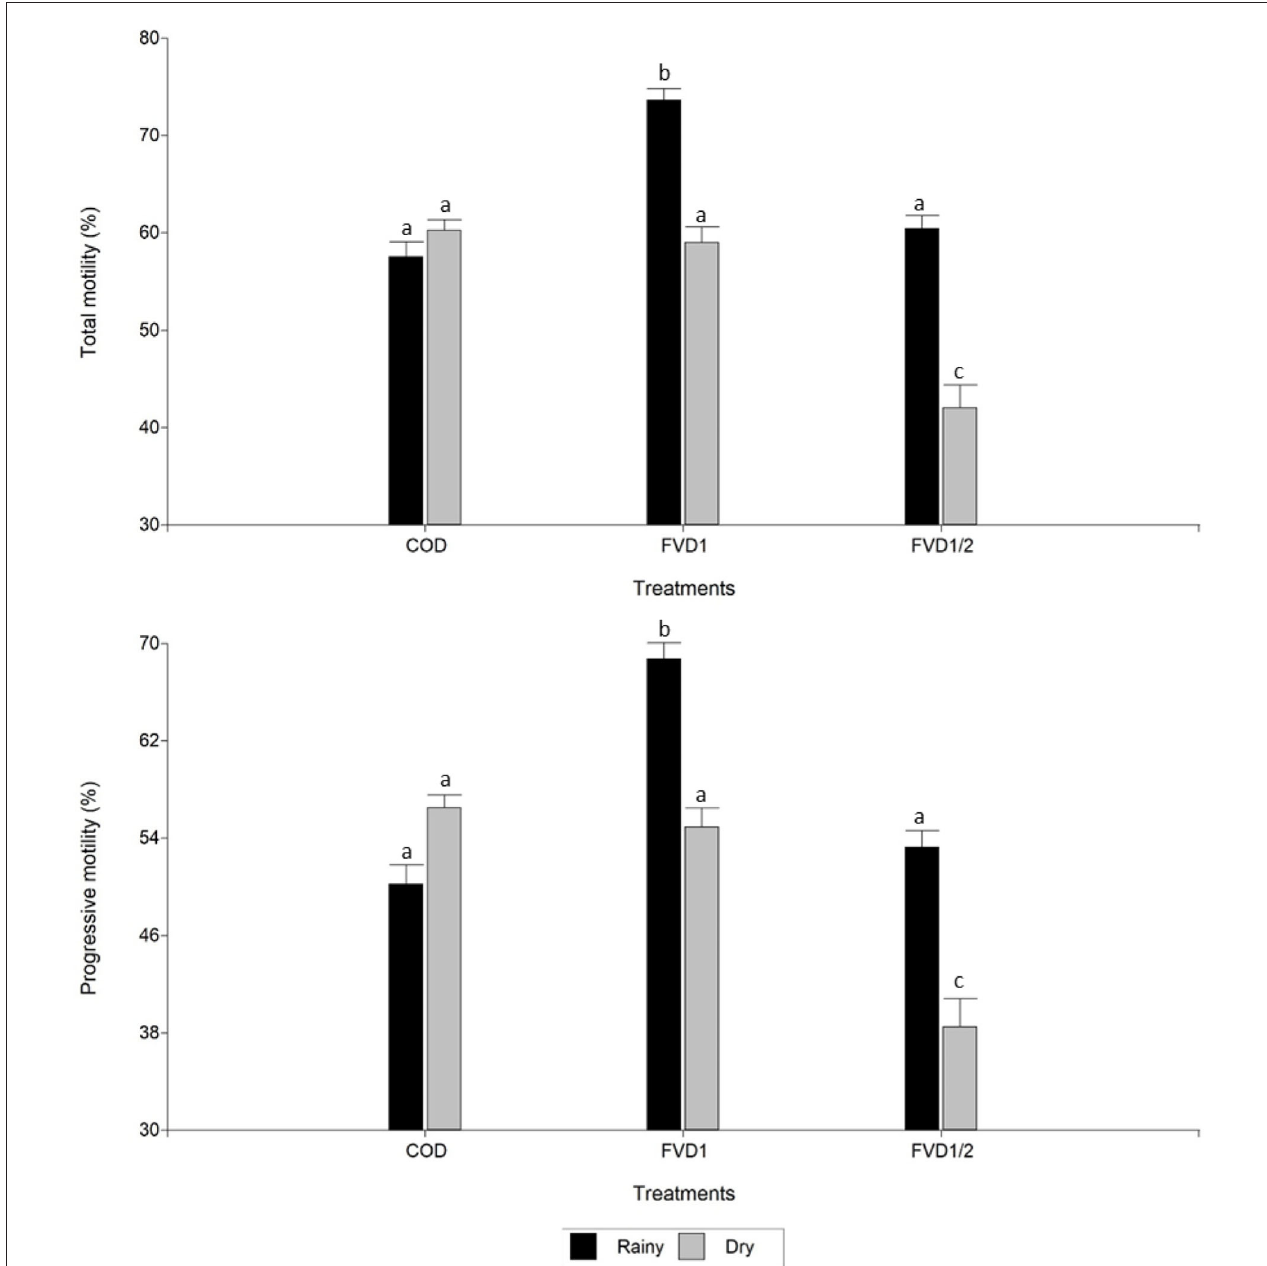
FIGURE 1 | Total and progressive motilities of boar semen by season according to dietary fat-soluble vitamin supplementation. Data are expressed as the mean ± standard error of the mean. COD, control group ( n = 11 ejaculates); FVD1, 100% fat-soluble vitamin supplementation group ( n = 20 ejaculates); FVD ½ , 50% fat-soluble vitamin supplementation group ( n = 27 ejaculates). a − c Least square means within each treatment with differing letters differ significantly ( P < 0.05).